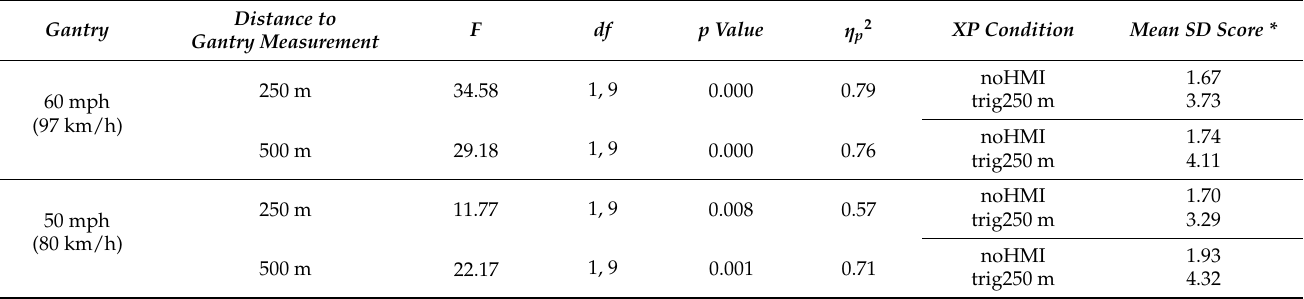
Table 13. Repeated measures ANOVA conducted to compare speed homogeneity between the noHMI and the trig250 m condition for the same sequence of gantries. Scores reported in km/h. Distance to Gantry Gantry Measurement